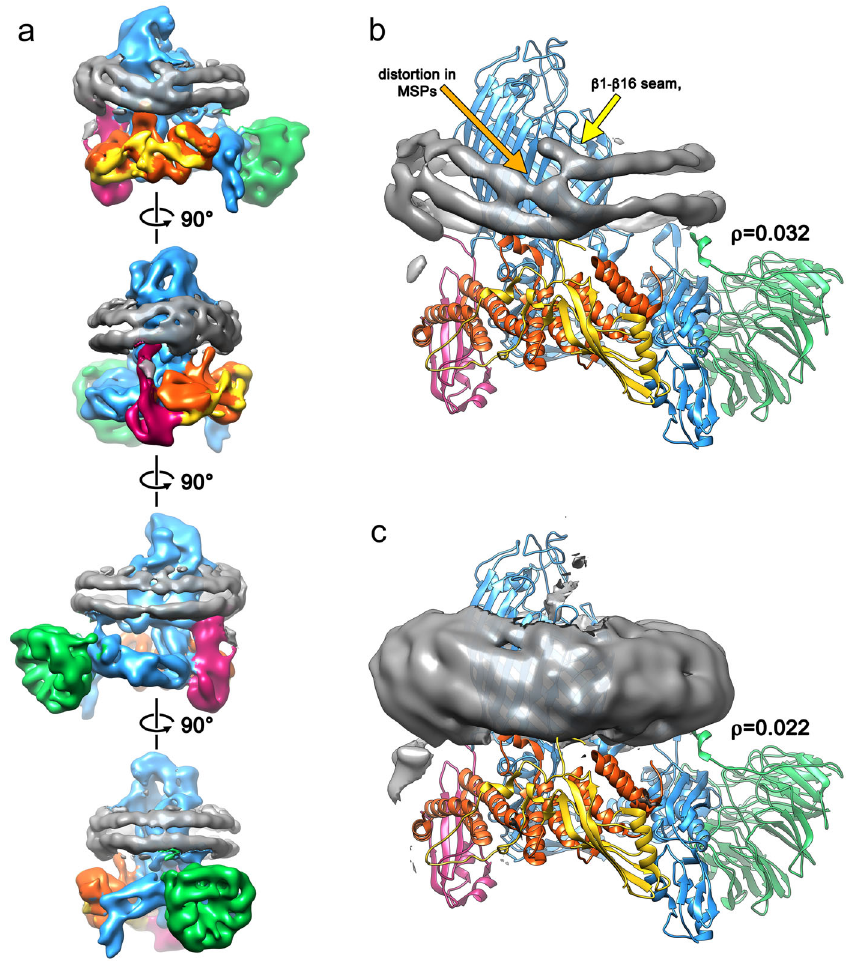
Fig. 3 The cryo-EM structure of BAM reveals distortion of the lipid nanodisc MSPs. a Cryo-EM map of the consensus structure of the BAM-containing MSP1D1 nanodisc with all fi ve BAM subunits and nanodisc density colour coded as in Fig. 1 and the nanodisc density in grey. Each panel represents a 90° rotation around the axis shown. The cryo-EM density for the membrane-scaffold proteins is shown with the fi tted atomic model of the BAM complex at low contour level ( ρ = 0.032; panel b ) and high contour level ( ρ = 0.022; panel c ) showing distortion of the MSP from the expected planar geometry adjacent to the BamA lateral